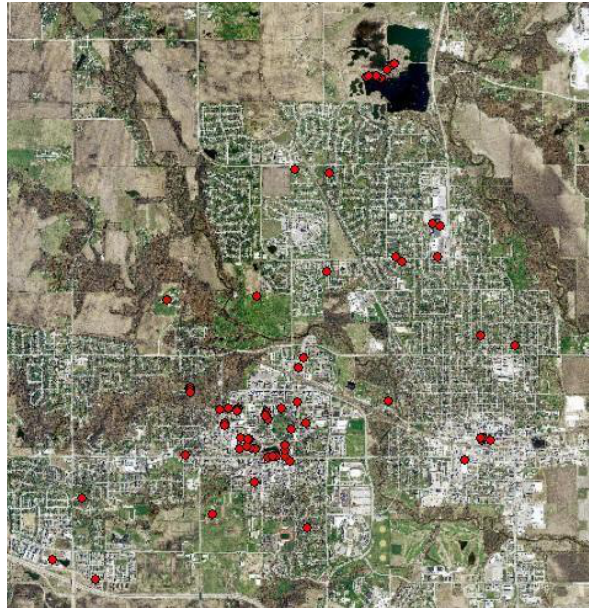
Figure 4. The location of power places in Ames,